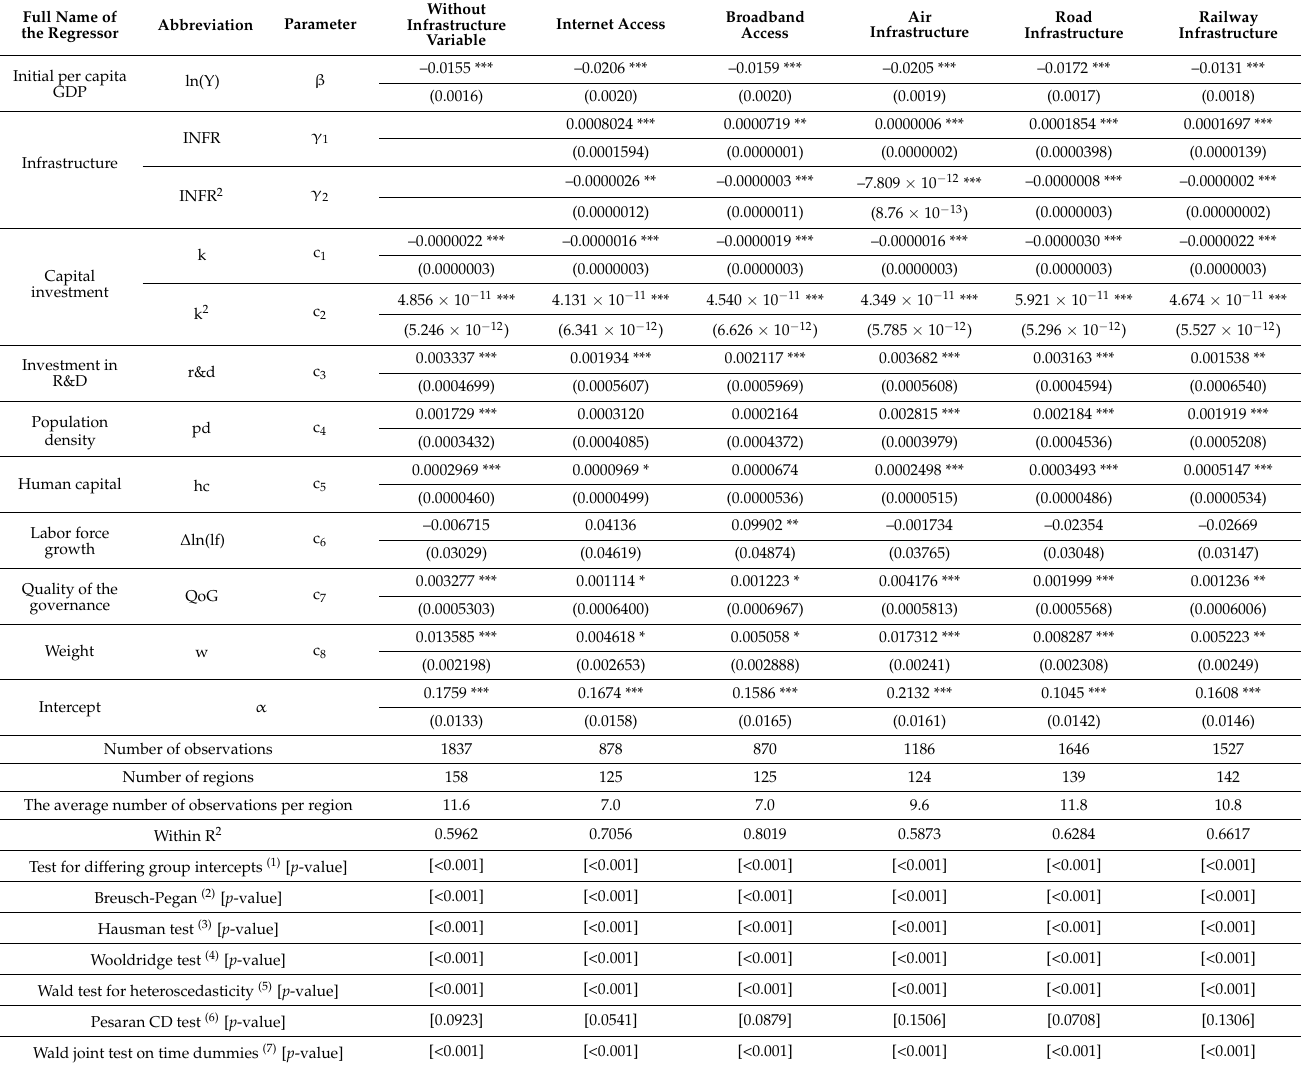
Table 2. Fixed effects estimates of Equation (1). Dependent variable—5-year forward-looking average growth